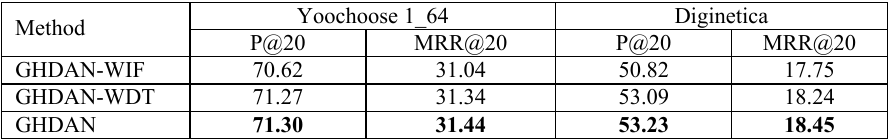
Table 3. Performances of different comparison methods on the two datasets.